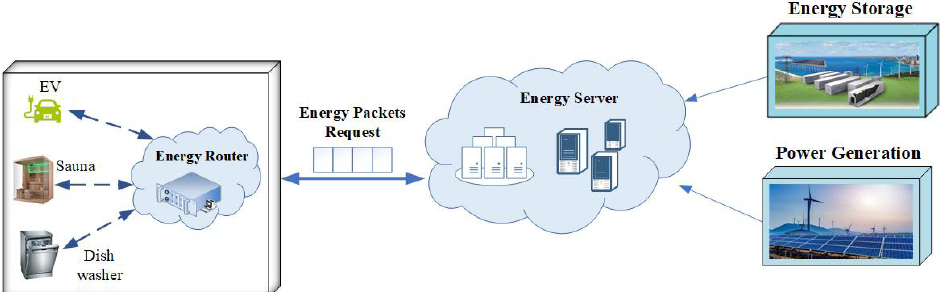
Figure 1. Example of the system architecture of the proposed solution. There are three applications with intelligent switches (e.g., EV, dishwasher and sauna) that have a communication link to a relay node (Energy Router). The relay node communicates by sending requests for virtualized energy packets via a data network to the Energy Server. The communication is two-way. The communication links can use different technologies. Since the solution is not strongly constrained by latency, packet retransmissions can be used to guarantee reliability in each hop. In the proposed packetized management algorithm, the energy server allocates an exclusive shared pool of energy resources to a pre-defined set of specific flexible